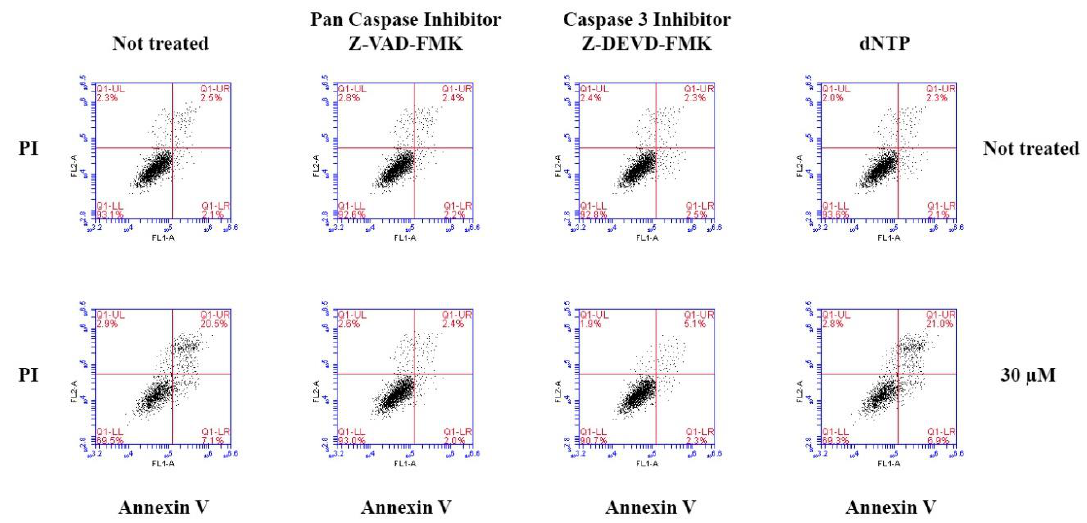
Figure 6. The effects of a caspase 3 inhibitor, a pan caspase and nucleoside on compound 7 -induced apoptosis in MCF-7 cells.